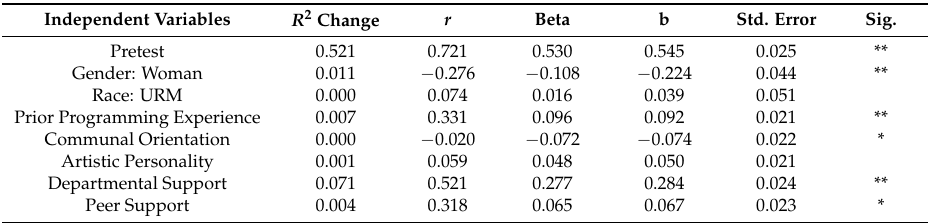
Table 3. Linear Regression Predicting Sense of Belonging in Computing ( n =